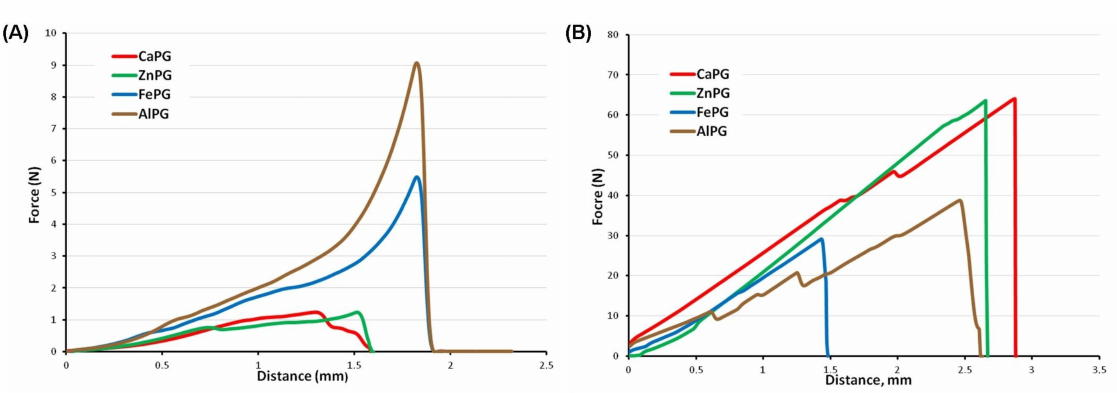
Figure 2. Mean ( n = 10) force overtime curve of the wet ( A ) and dried ( B ) CaPG, ZnPG, FePG, and AlPG beads.